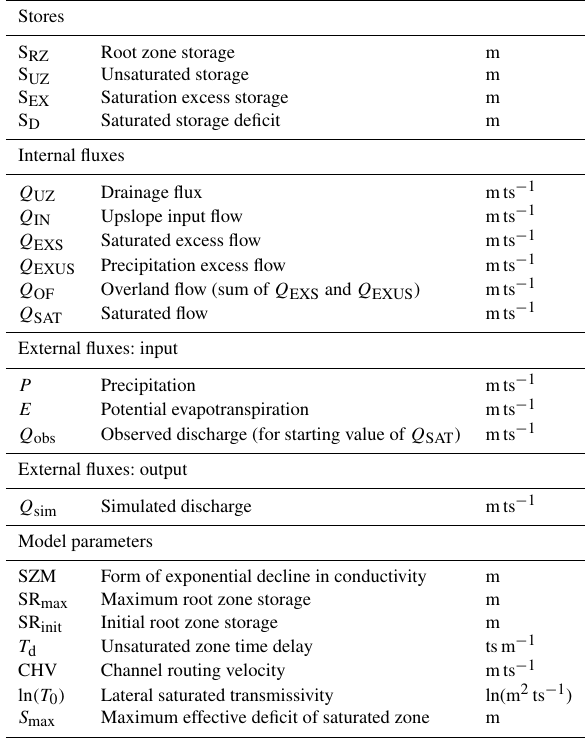
Table 1. Overview of DECIPHeR’s stores, fluxes and